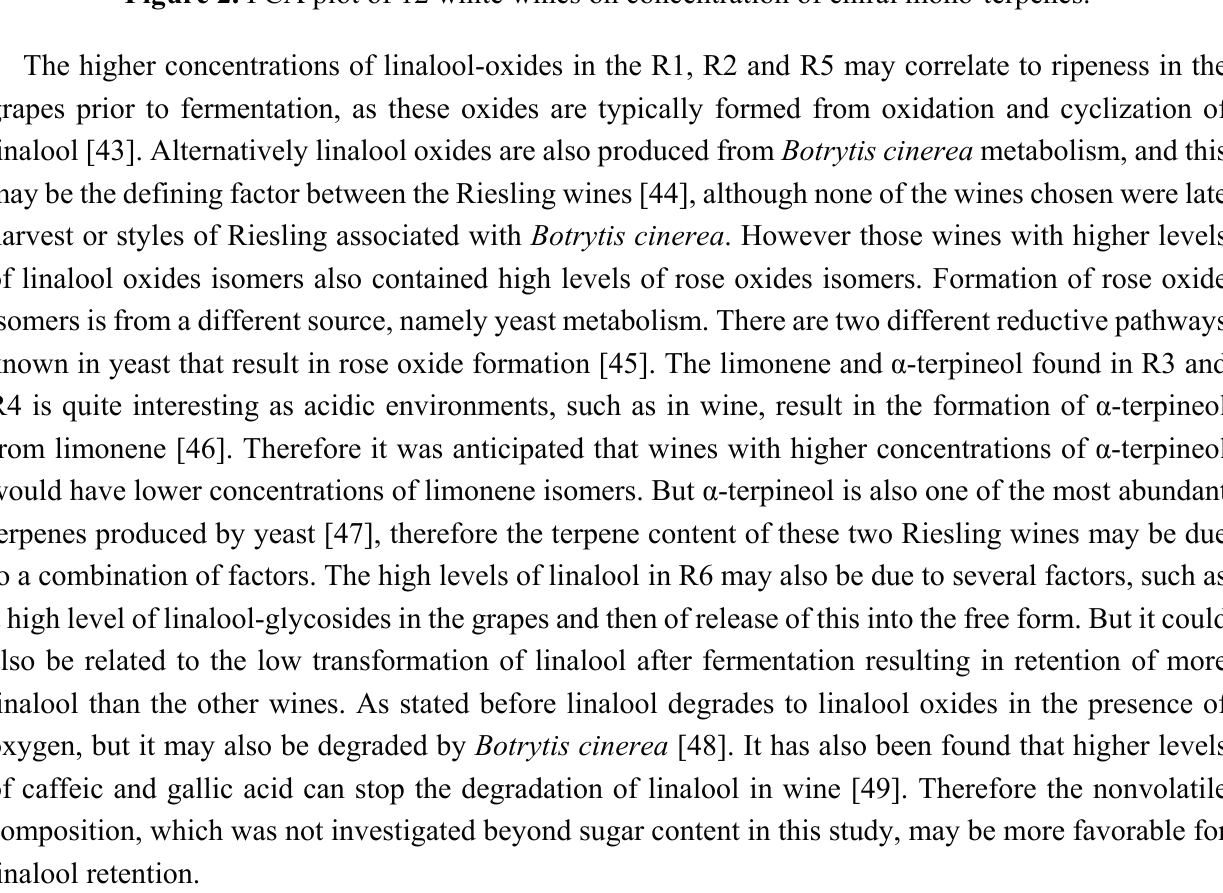
Figure 2. PCA plot of 12 white wines on concentration of chiral